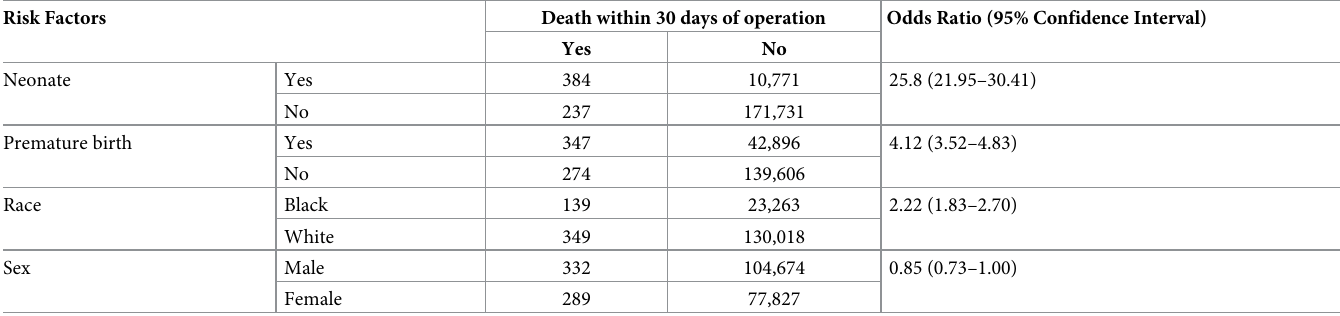
Table 1. Patient characteristics and risk for death after surgery. Risk